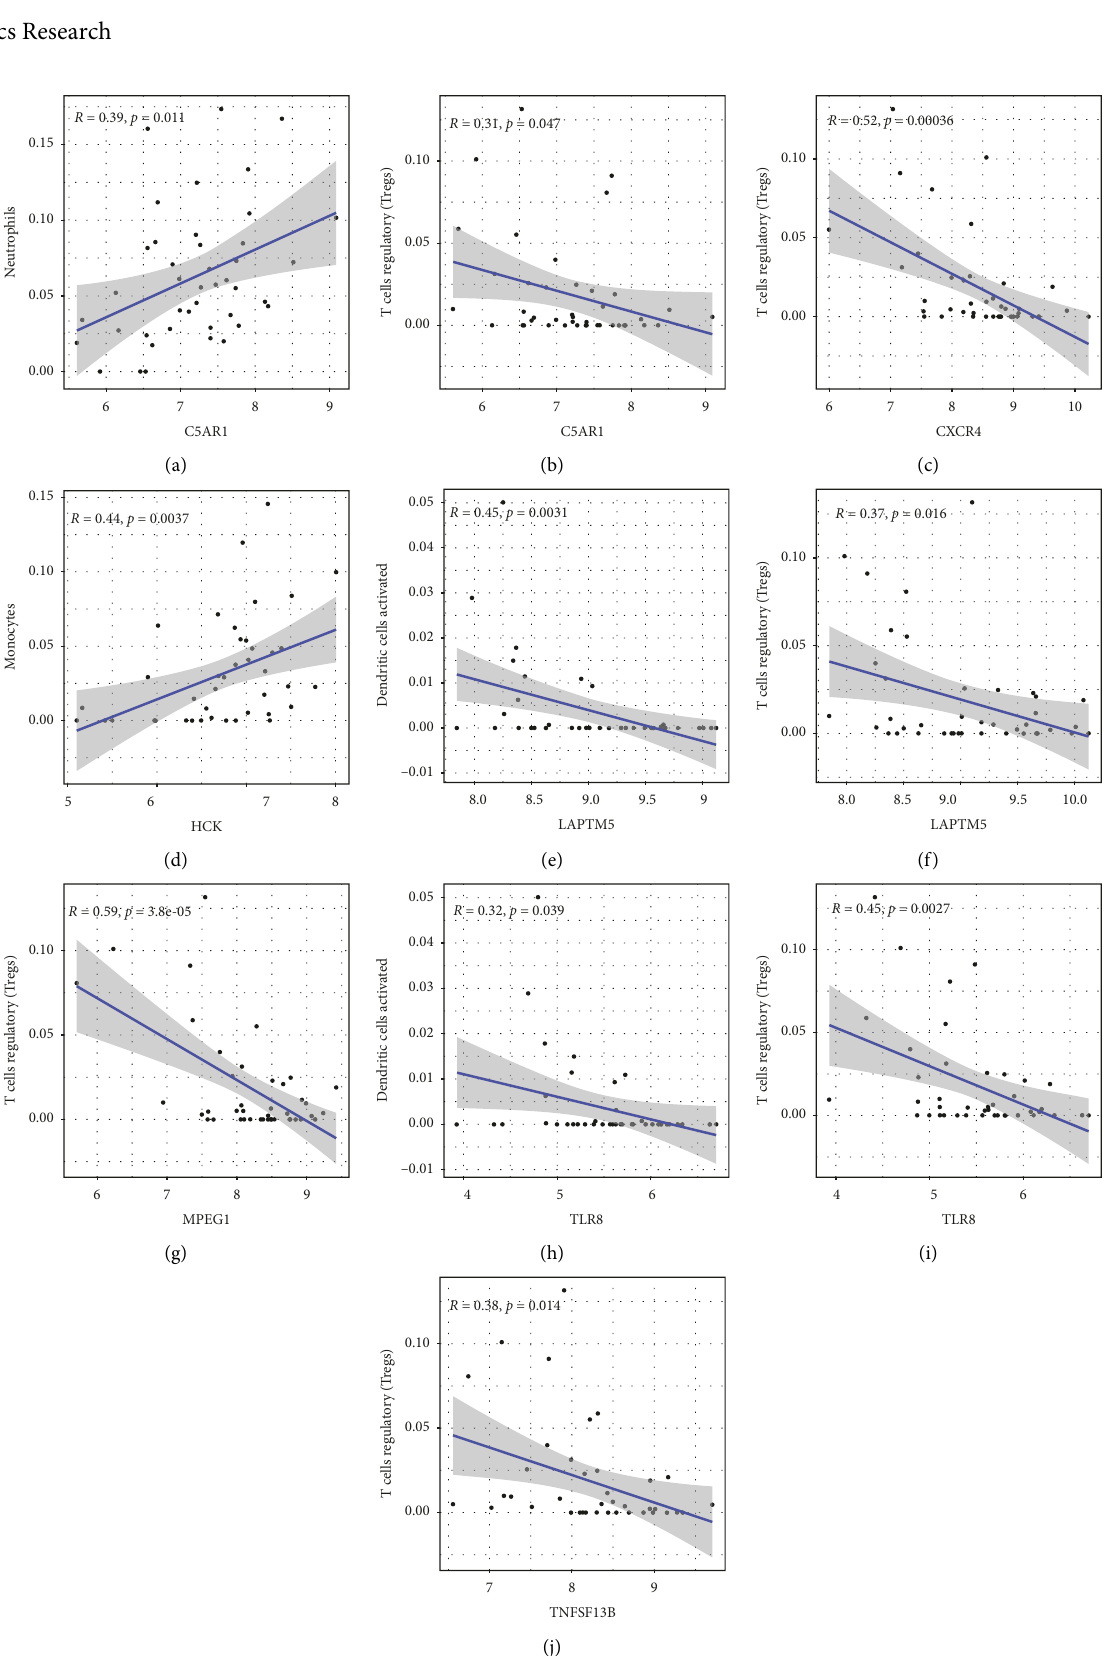
Figure 9: Pearson correlation coefficients were used to calculate the relationship between hub genes and immune cells related to atrial fibrillation